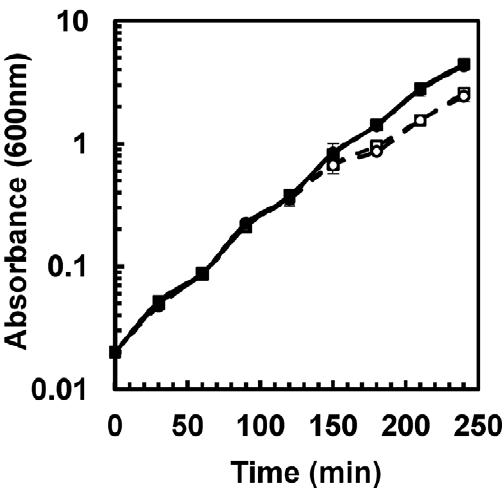
Figure 1. Comparison of the growth of Bacillus cereus ATCC14579 and its isogenic D bc4707 mutant. Growth was assayed for the wild type (circles) and the mutant (squares) by monitoring the absorbance at 600 nm in LB medium (solid lines; closed symbols) and during 50 m g/ml bile salts stress initiated at OD 600 of 0.5 (dashed lines; open symbols). Shown are averages and standard deviations of two independent experiments.